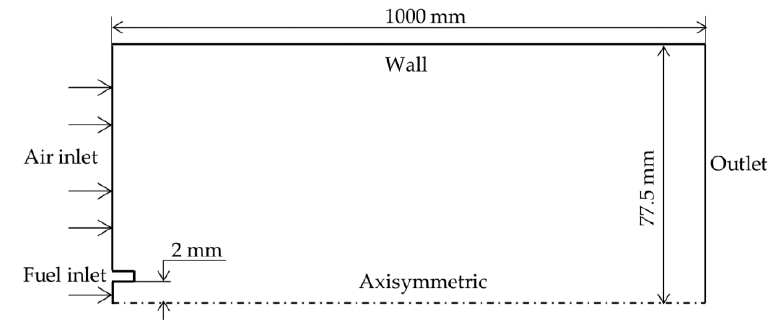
Figure 3. Schematic diagram of the furnace of experiment [7].